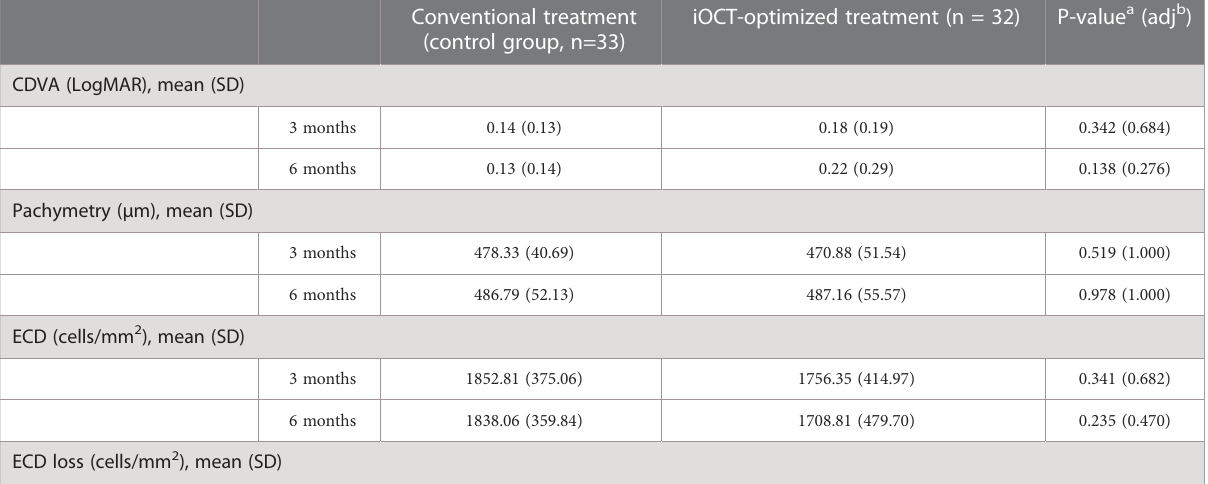
TABLE 2 Primary and secondary outcomes after conventional treatment and iOCT-optimized